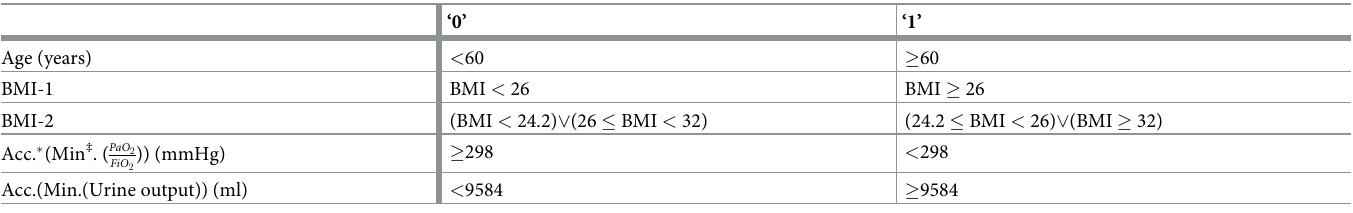
Table 2. Critical values for binarization of the most important COVID-19 patient features. ‘0’ ‘1’ Age (years) < 60 � 60 BMI-1 BMI < 26 BMI � 26 BMI-2 (BMI < 24.2) _ (26 � BMI < 32) (24.2 � BMI < 26) _ (BMI � 32) � 298 <